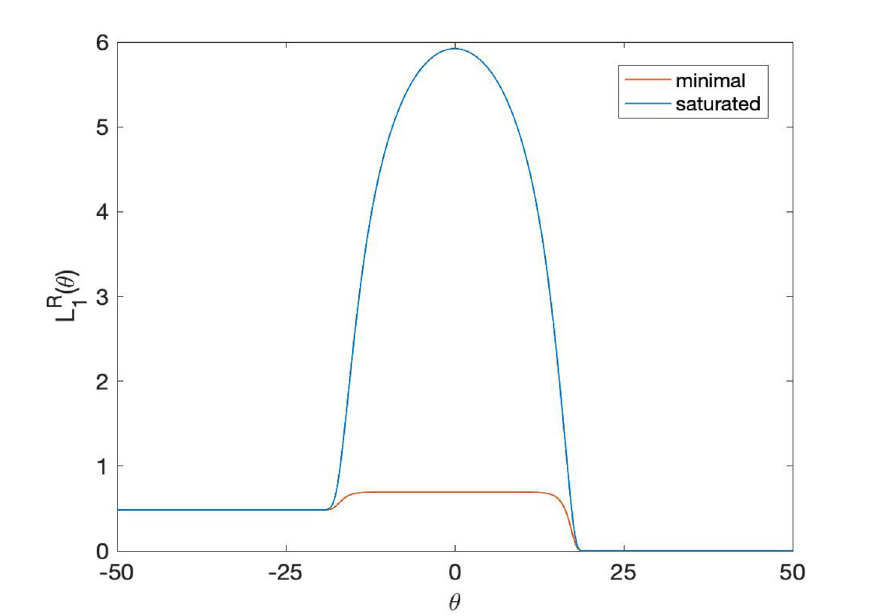
mR ) vs log( mR ) by solving TBA numeri- b b